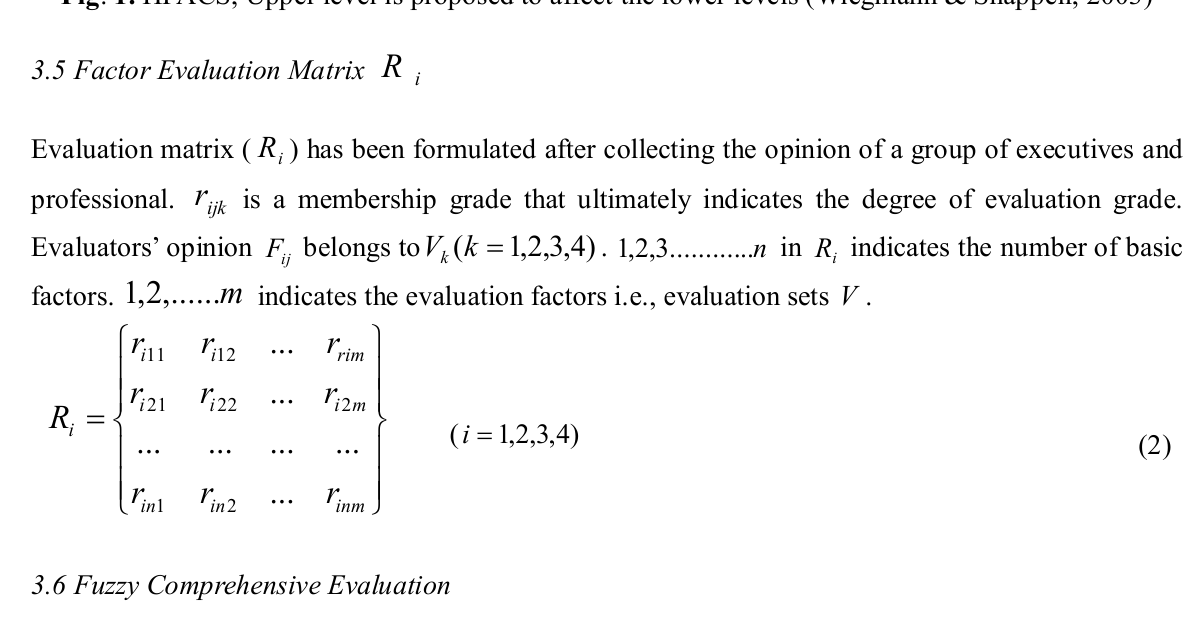
Fig . 1. HFACS, Upper level is proposed to affect the lower levels (Wiegmann & Shappell,